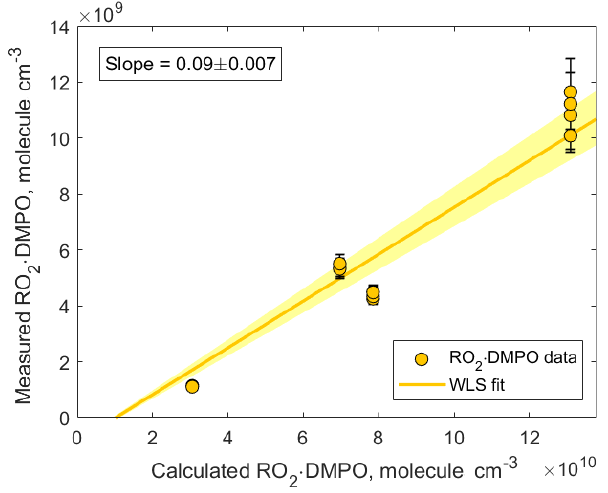
Figure 7. Correlation plot comparing measured and calculated con- (cid:113) centrations of CH 3 C ( =O ) CH 2 OO DMPO. The adducts were de- (cid:113) (cid:113) tected using NH + CIMS as CH 3 C ( =O ) CH 2 OO DMPO NH + 4 4 ( m/z 220.142). The slope was calculated using weighted least squares (WLS). The 95% confidence interval was estimated via a Monte Carlo simulation ( N = 5000) and is shown using yellow